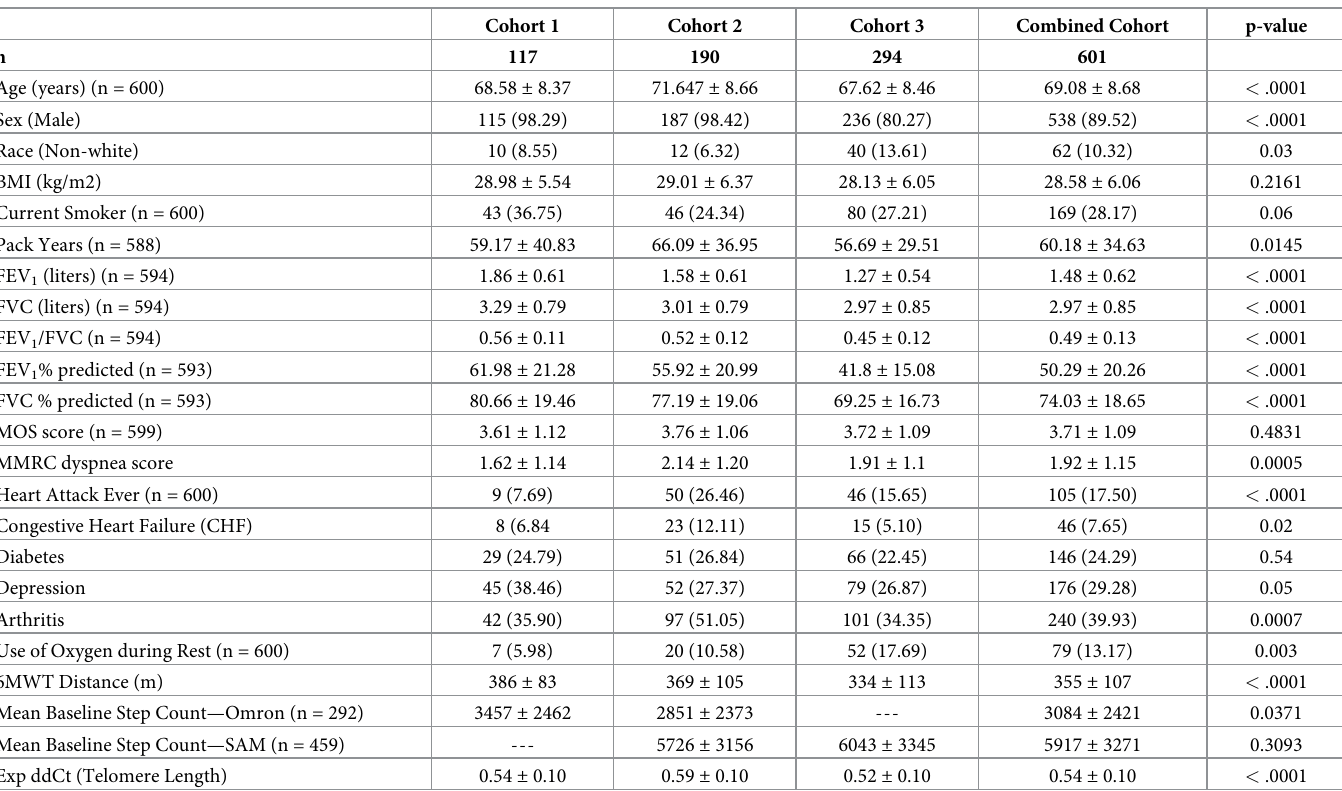
Table 3. Participant characteristics by